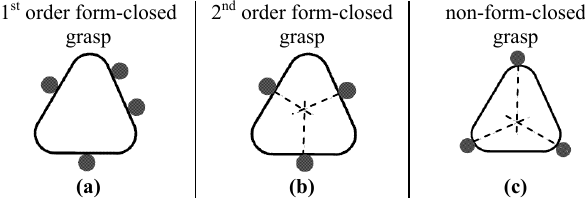
Figure 1. Illustration of grasp types (figures taken from Cheong (2006)): in situation (a) the object is totally immobilized, in situation (b) it can move with an infinitesimal rotation around the point of concurrency of the contact normals, in situation (c) the object is free to rotate around that point. This phenomenon can be modeled considering the local curvatures of the contact surfaces as explained in Van der Stappen et al.